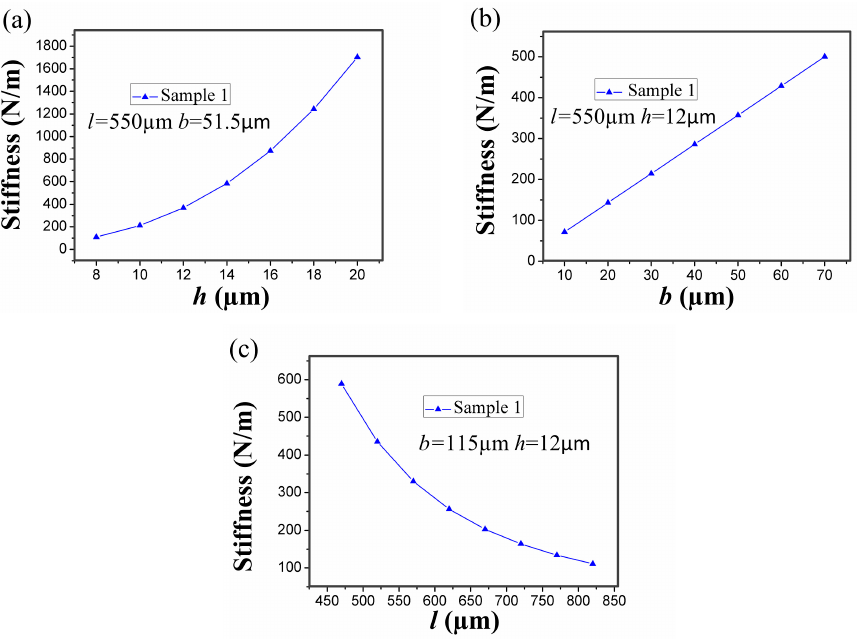
Figure 2. Dependence of analytical stiffness k of the stationary electrode on its geometric parameters ( h , b , l ): ( a ) the stiffness k versus the thickness h ; ( b ) the stiffness k versus the width b ; and ( c ) the stiffness k versus the length l .